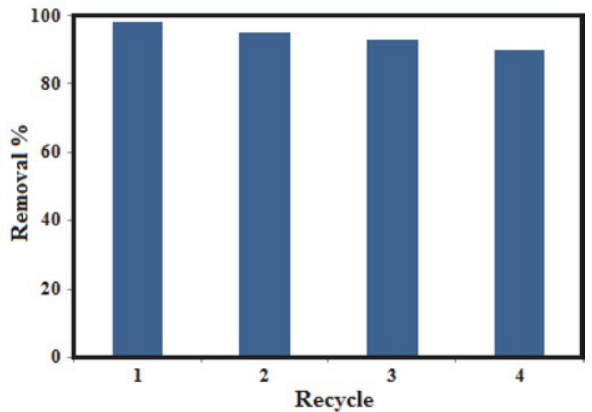
O on MB removal 3 4